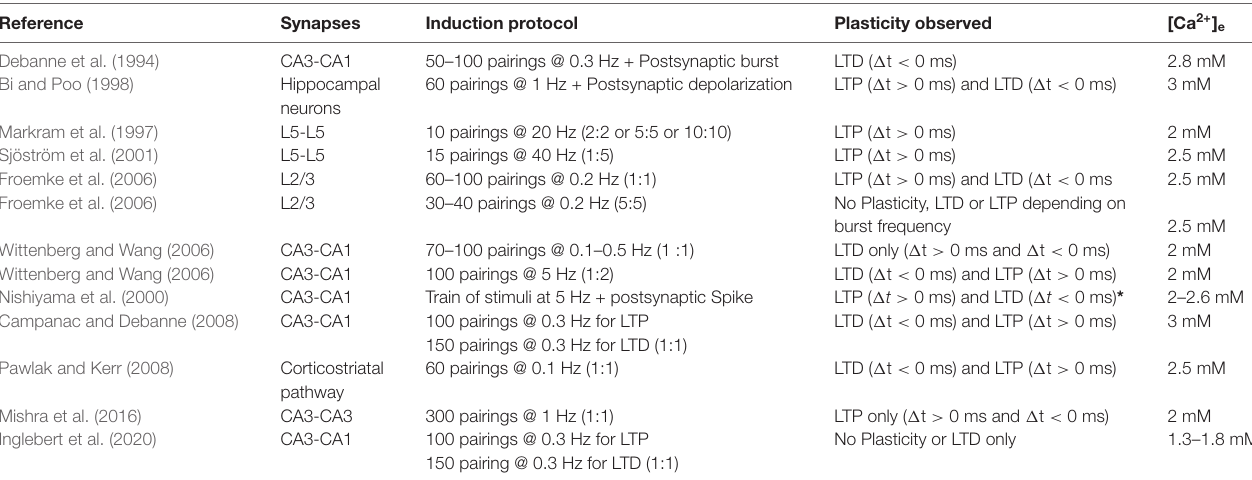
TABLE 1 | Selected publications on Spike Timing-Dependent